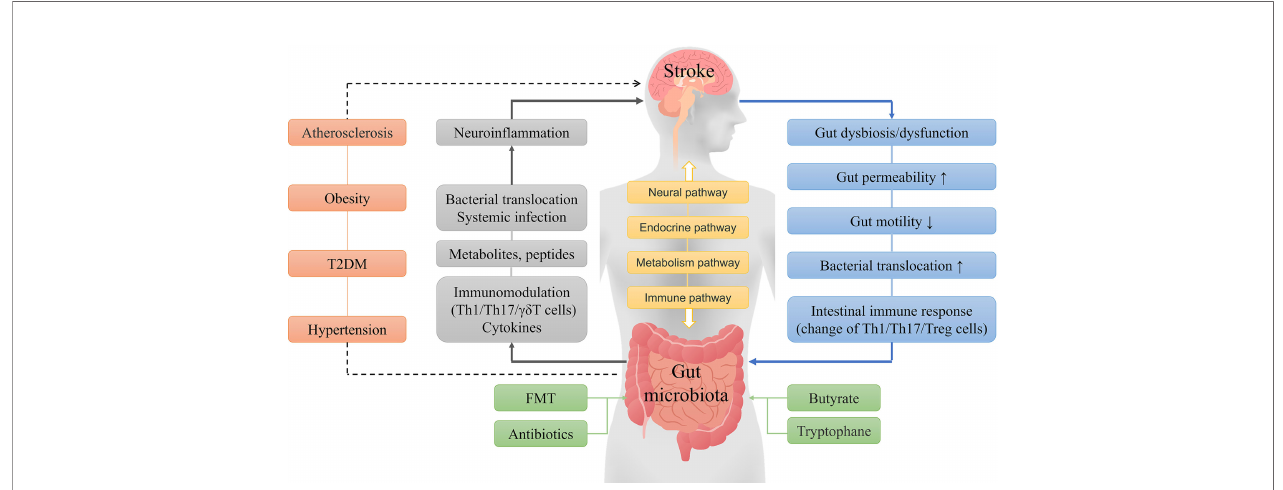
FIGURE 1 | General concept of interactions between the gut microbiota and ischemic stroke. The brain and gut microbiota interact with each other through neural, endocrine, metabolic and immune pathways. A stroke can cause a series of reactions, such as gut microbiota disorder, microbial composition changes, and immune responses, while gut dysbiosis can lead to metabolic and immune response changes, systemic in fl ammation, and other reactions that result in increased neuroin fl ammation and poor stroke outcomes. Furthermore, hypertension, obesity, diabetes, and atherosclerosis are independent risk factors for stroke, and the gut microbiota may indirectly in fl uence stroke by affecting these risk factors. Fecal microbiota transplantation, probiotics, butyrate, and tryptophane can improve the prognosis of stroke by improving the composition of the gut